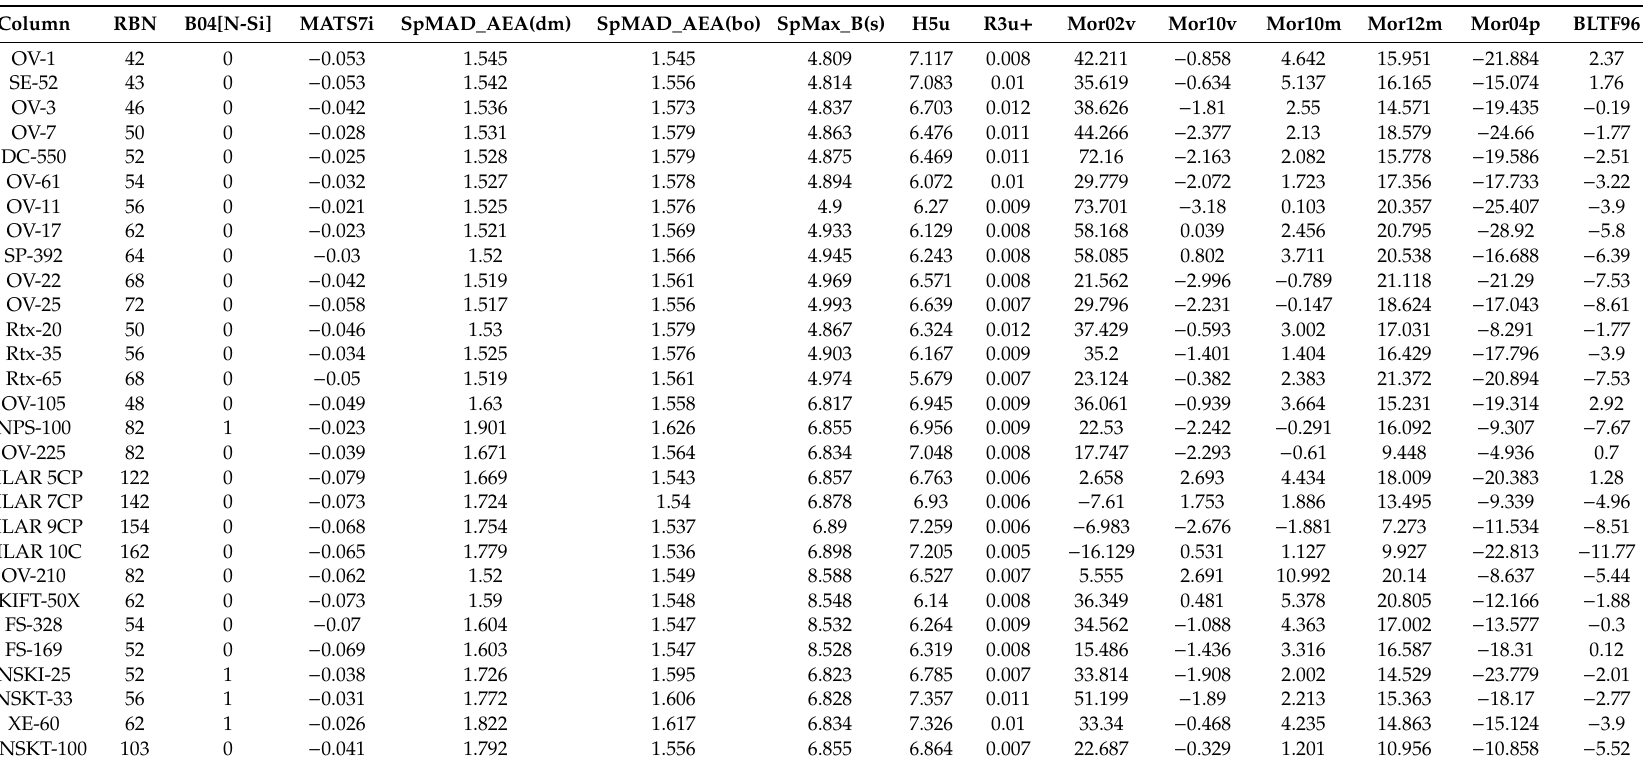
Table A1. Values of the significant molecular descriptors associated to the 29 poly(siloxanes) stationary